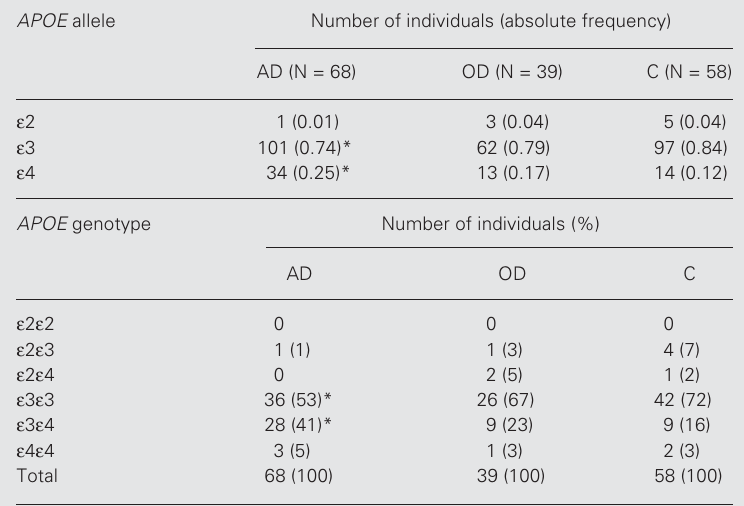
Table 1. Apolipoprotein E ( APOE ) allele and genotype frequencies in patients with Alzheimer’s disease (AD), other late-onset dementias (OD) and controls (C). APOE